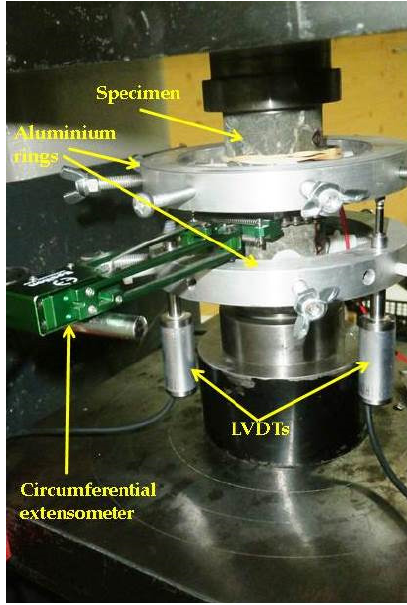
Figure 2. Experimental configuration for axial strain measurements.